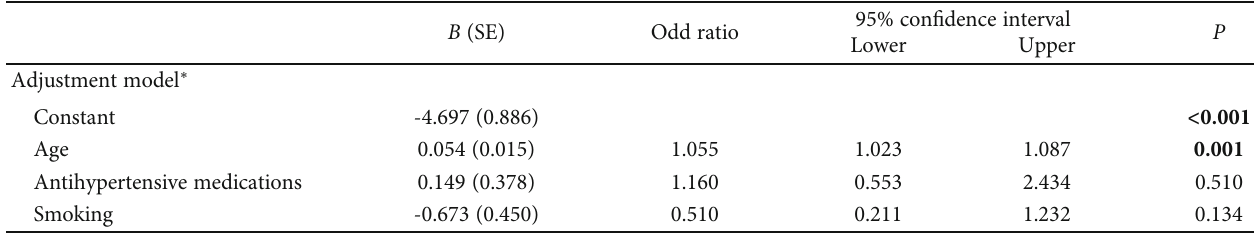
Table 3: Model of adjusted signi fi cant parameters of